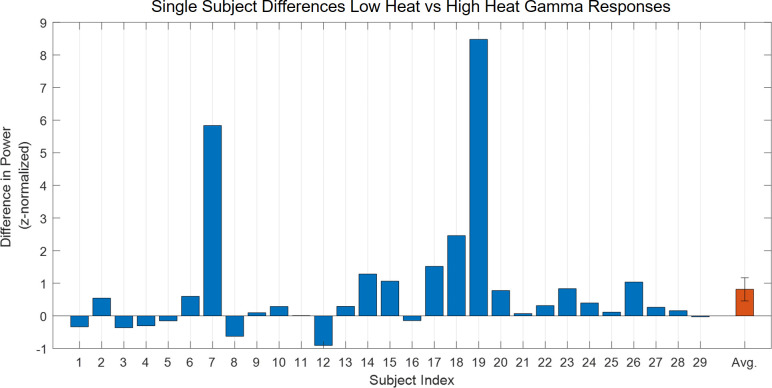
Difference for the main effect of stimulus intensity in the gamma band (averaged over 60–100 Hz, 1250–1600 ms) in power values for all high heat vs. low heat conditions with a valid modality cue (expect heat receive heat) for each subject, respectively.